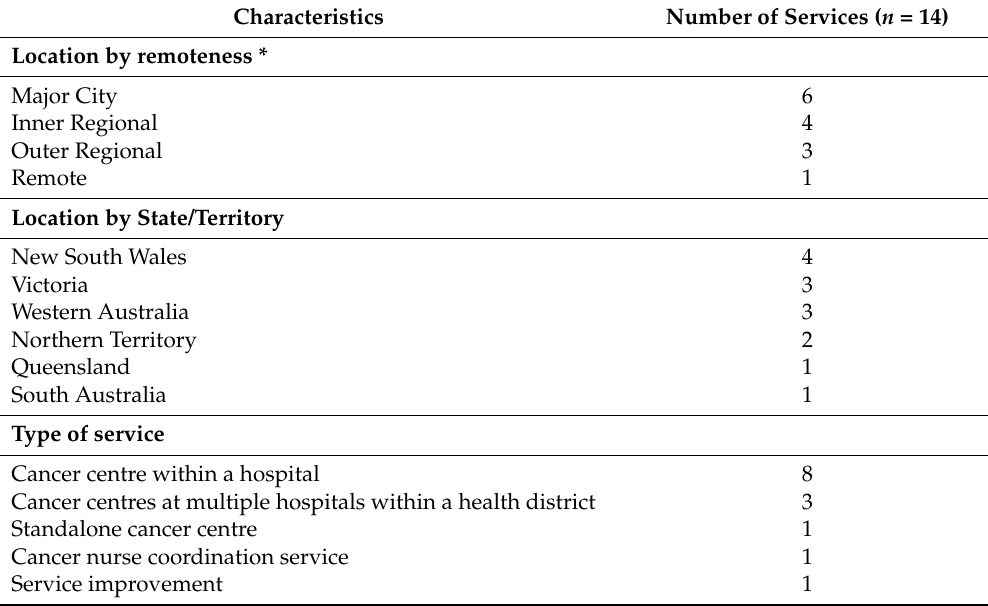
Table 2. Characteristics of participating cancer service